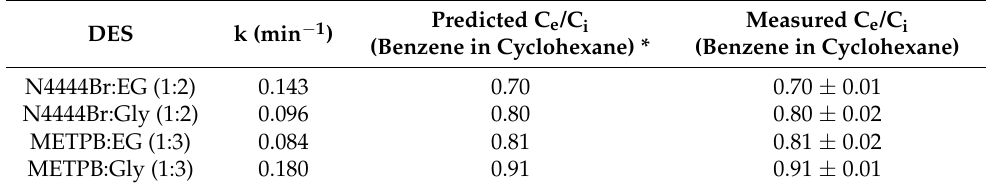
Figure 4. First Order Kinetic Fit for ( A ) N4444Br:Gly and METPB:EG and ( B ) N4444Br:EG and METPB:Gly. Table 4. Time Coefficient and Error Times for Benzene Mass Transfer into DES from Cyclohexane at 25 ◦